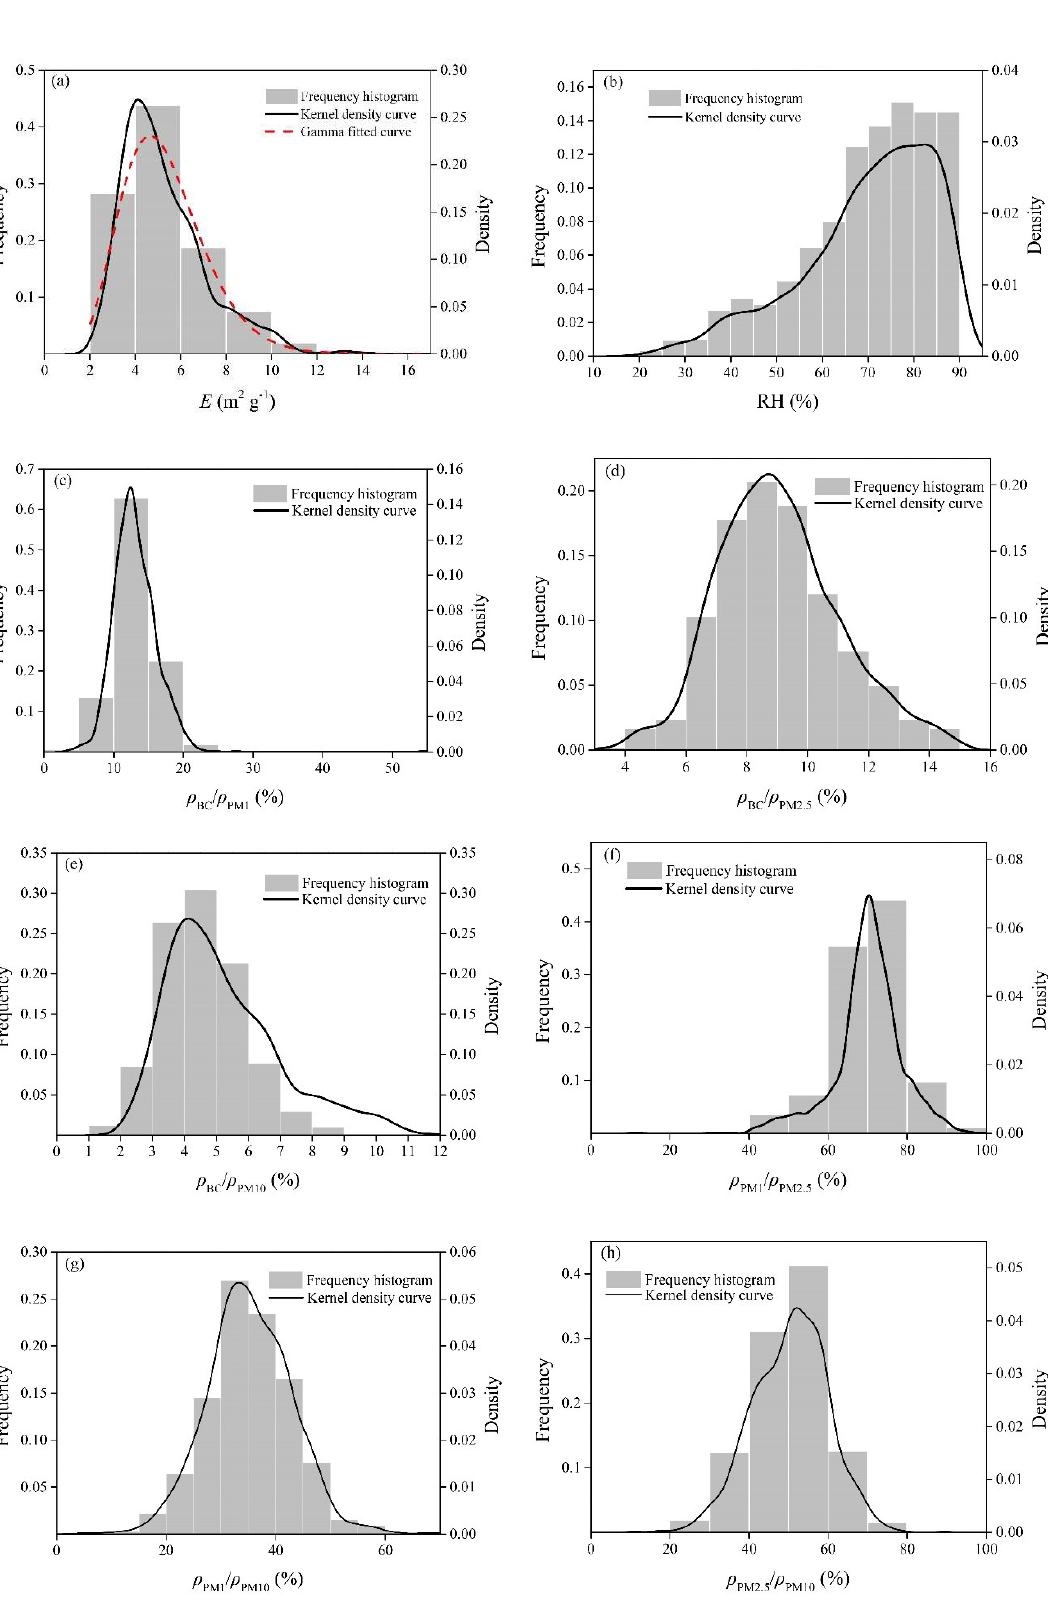
Figure 3. The framework of non-stationarity analysis of the aerosol extinction coefficient per unit of mass.